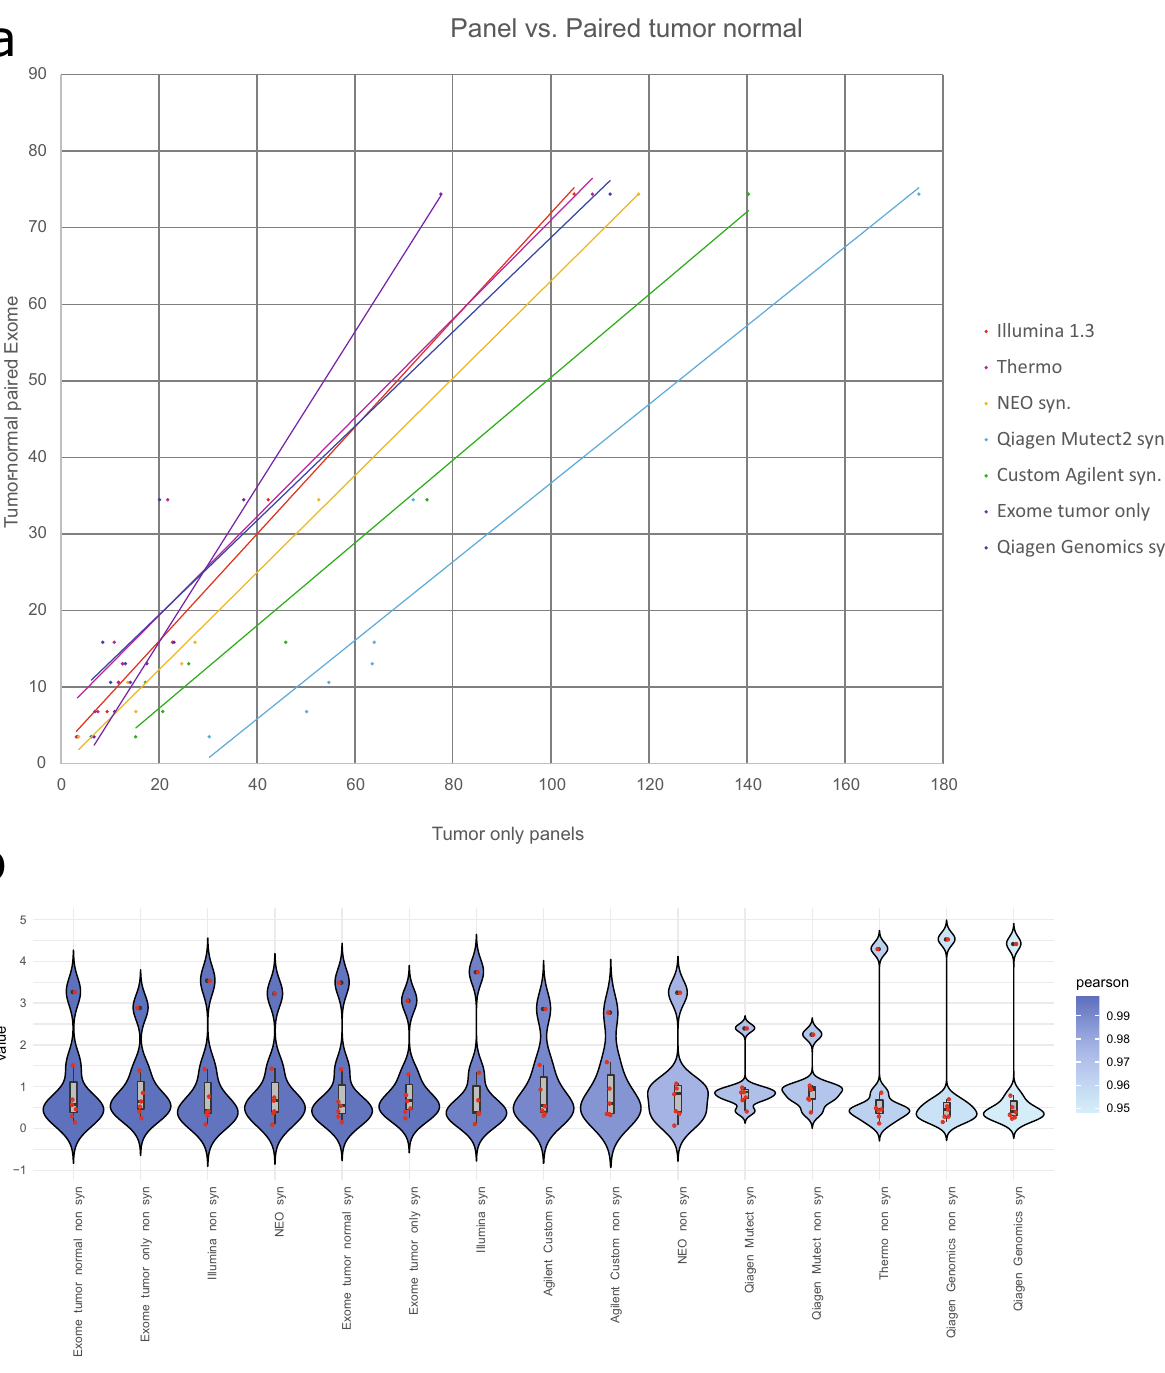
Figure 2. ( a ) TMB values of the panels (x-axis) compared to results from paired tumor-normal WES of non synonymous variants (y-axis). If bioinformatic pipelines delivered results including coding synonymous variants as well as excluding them, the ones with the highest correlation to the tumor-normal paired analysis are shown. Panels: Illumina—TSO500; NEO—NEOplus v2 RUO TMB (NEO New Oncology); Agilent custom—custom panel Agilent SureSelect XT HS; Exome tumor only—WES Agilent SureSelect XT HS Human All Exon v6 panel; Qiagen Mutect2—Qiagen TMB v3.0 (Qiagen) analyzed with Mutect2 in-house pipeline; Qiagen Genomics— Qiagen TMB v3.0 (Qiagen) analyzed with Qiagen Genomics Workbench 12.0.2.; Thermo—Oncomine Tumor Mutation Load assay (Thermo Fisher Scientific); syn.—Analysis includes synonymous variants. ( b ) Average normalized TMB values (y-axis) for all panels (x-axis) shown as violin plots. The red dots are the samples for the panels. The outer shape represents the density distribution and filling heat map corresponds to the Pearson correlation to exome t-n. The lower and upper hinges correspond to the first and third quartiles (the 25th and 75th percentiles) with 95% confidence